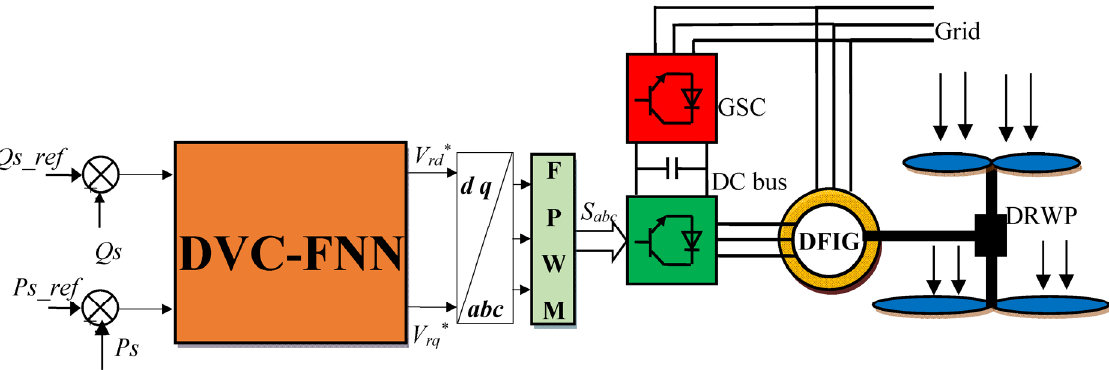
Figure 10. DVC-FNN method of the DFIG-DRWP.